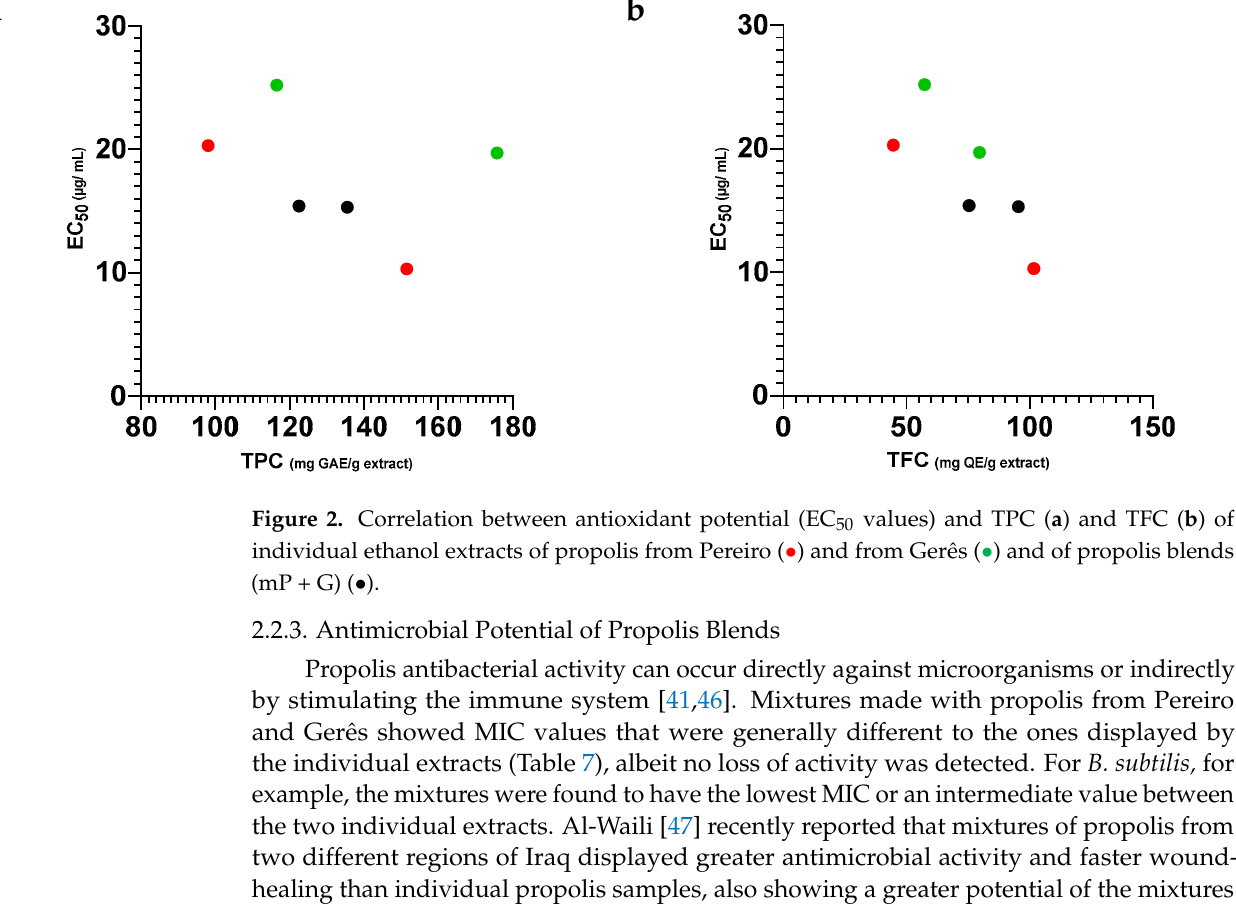
Table 7. MIC values ( µ g/ ml) of P.EEs and G.EEs blends against Bacillus subtilis ,